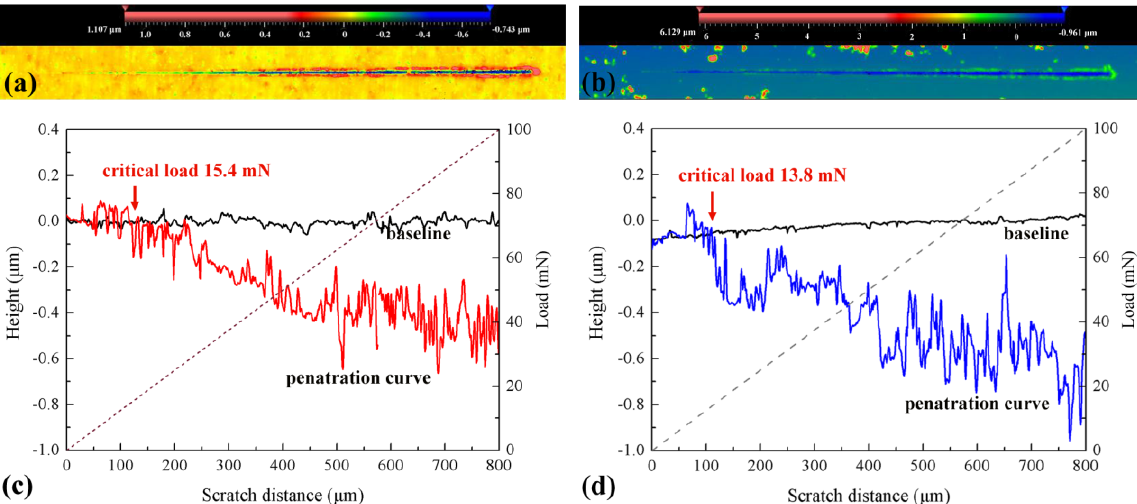
Figure 3. Results of the nano-scratch tests. Left: Results of Mefp -1 film on carbon steel. Right: Results of Mefp -1/graphene composite film on carbon steel. ( a , b ) Morphology of the scratch. ( c , d ) The penetration curves as a function of the scratch distance. The dashed line indicates the applied ramping load.